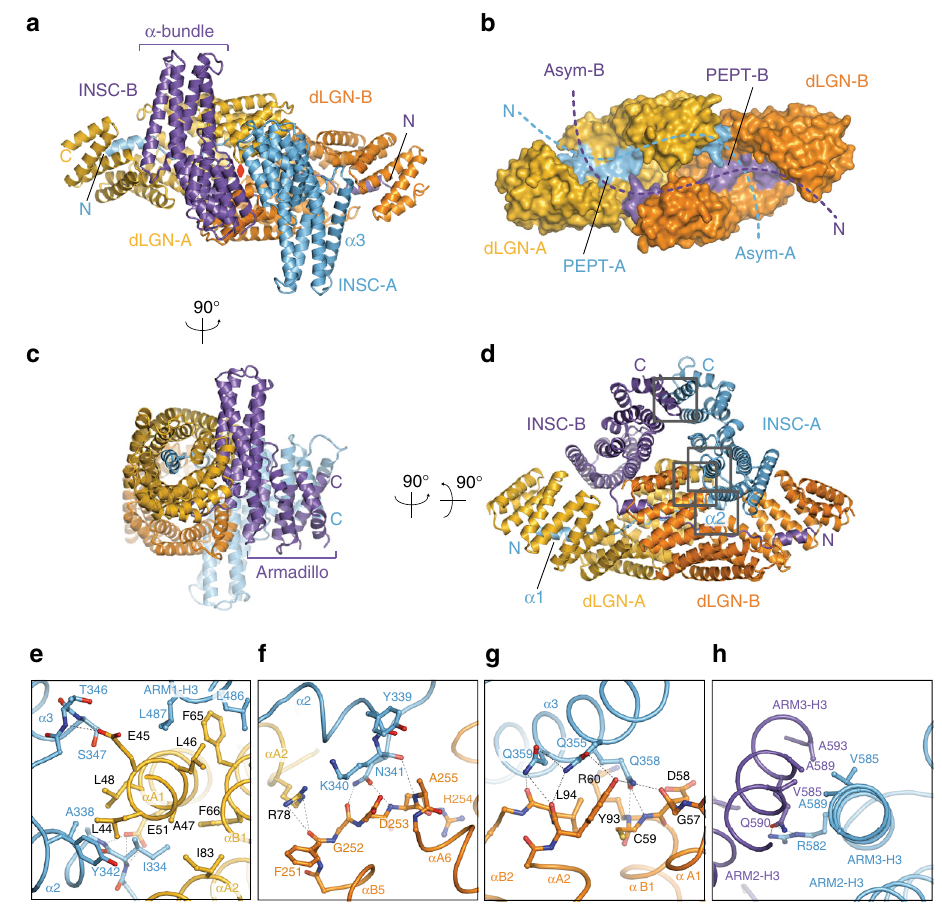
Fig. 1 Structure of the dLGN TPR :Insc ASYM complex. a – d Cartoon representation of the dLGN TPR :Insc ASYM tetramer in three orthogonal orientations. The two protomers of dLGN TPR are colored gold and orange, while the two Insc ASYM are in cyan and purple. The two-fold symmetry axis of the tetramer is marked as a red oval in a . b Surface representation of the arrangement of the dLGN TPR domains with the N-terminal fragments of Insc ASYM -labeled PEPT (Insc PEPT in the text) in the same orientation and colors as in a . e – h Close-up views of the interaction of Insc- A with the other subunits of the tetramer from the N terminus to the end of the polypeptide chain. The positions of the individual close-up views within the complex are indicated in d . Interacting residues at the interfaces are depicted in